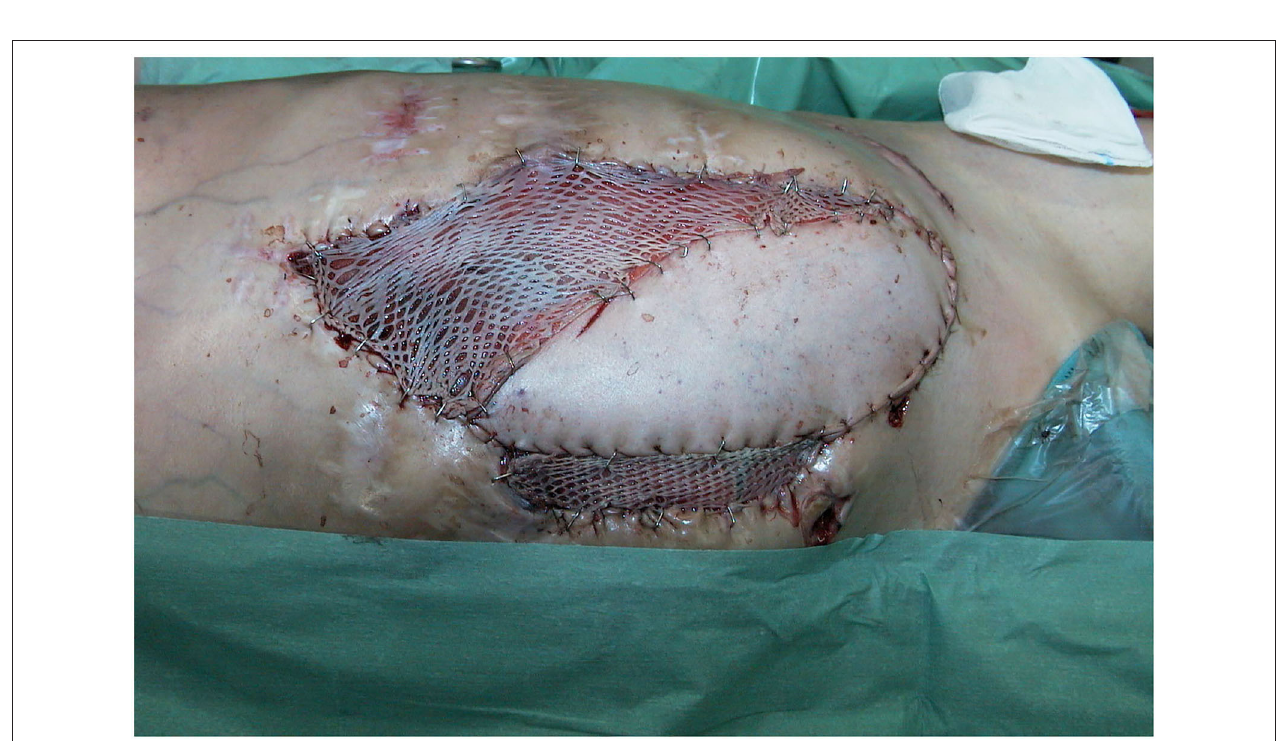
FIGURE 11 | Intraoperative view after skin graft mesh coverage of the exposed LDM flap.